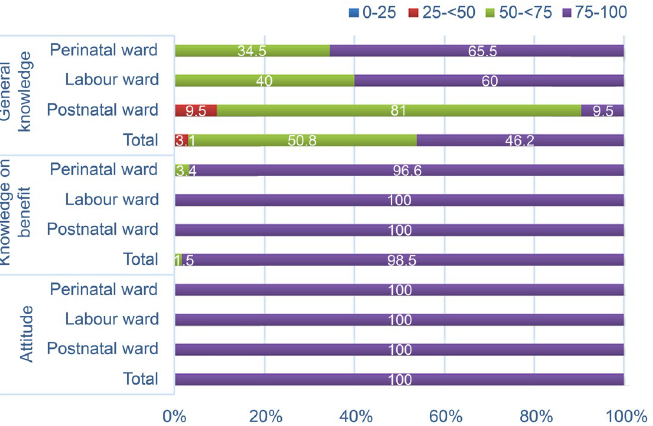
Fig 1. Percentages of correct answers on knowledge and attitude toward kangaroo mother care. General knowledge, knowledge on benefits, and attitude scores were grouped into four categories (scores 0 to 25, 25 to below 50, 50 to below 75, and 75 to 100). The figure represents the percentages of nurses based on those four score categories, with a score of 75–100 representing good knowledge or attitude.